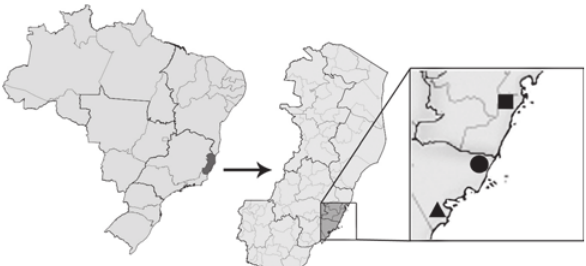
Figure 1. Map of Brazil indicating the location of the state of Espírito Santo and the locations of the sampling stations: ( (cid:2) ) Station 1, ( (cid:2) ) Station 2, ( (cid:3) ) Station